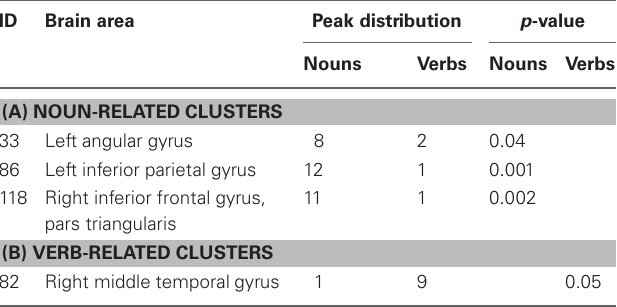
Table 3 | Noun- and verb-specific clusters as revealed by the meta-analytic procedure.